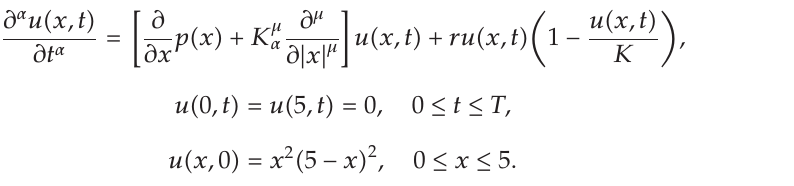
and μ (cid:7) 2 . 0 (cid:4) moves to the right as time increases, but the peak of the fractional order model in Figure 6 (cid:3) α (cid:7) 0 . 8 and μ (cid:7) 1 . 8 (cid:4) and Figure 7 (cid:3) α (cid:7) 0 . 5 and μ (cid:7) 1 . 5 (cid:4) does not